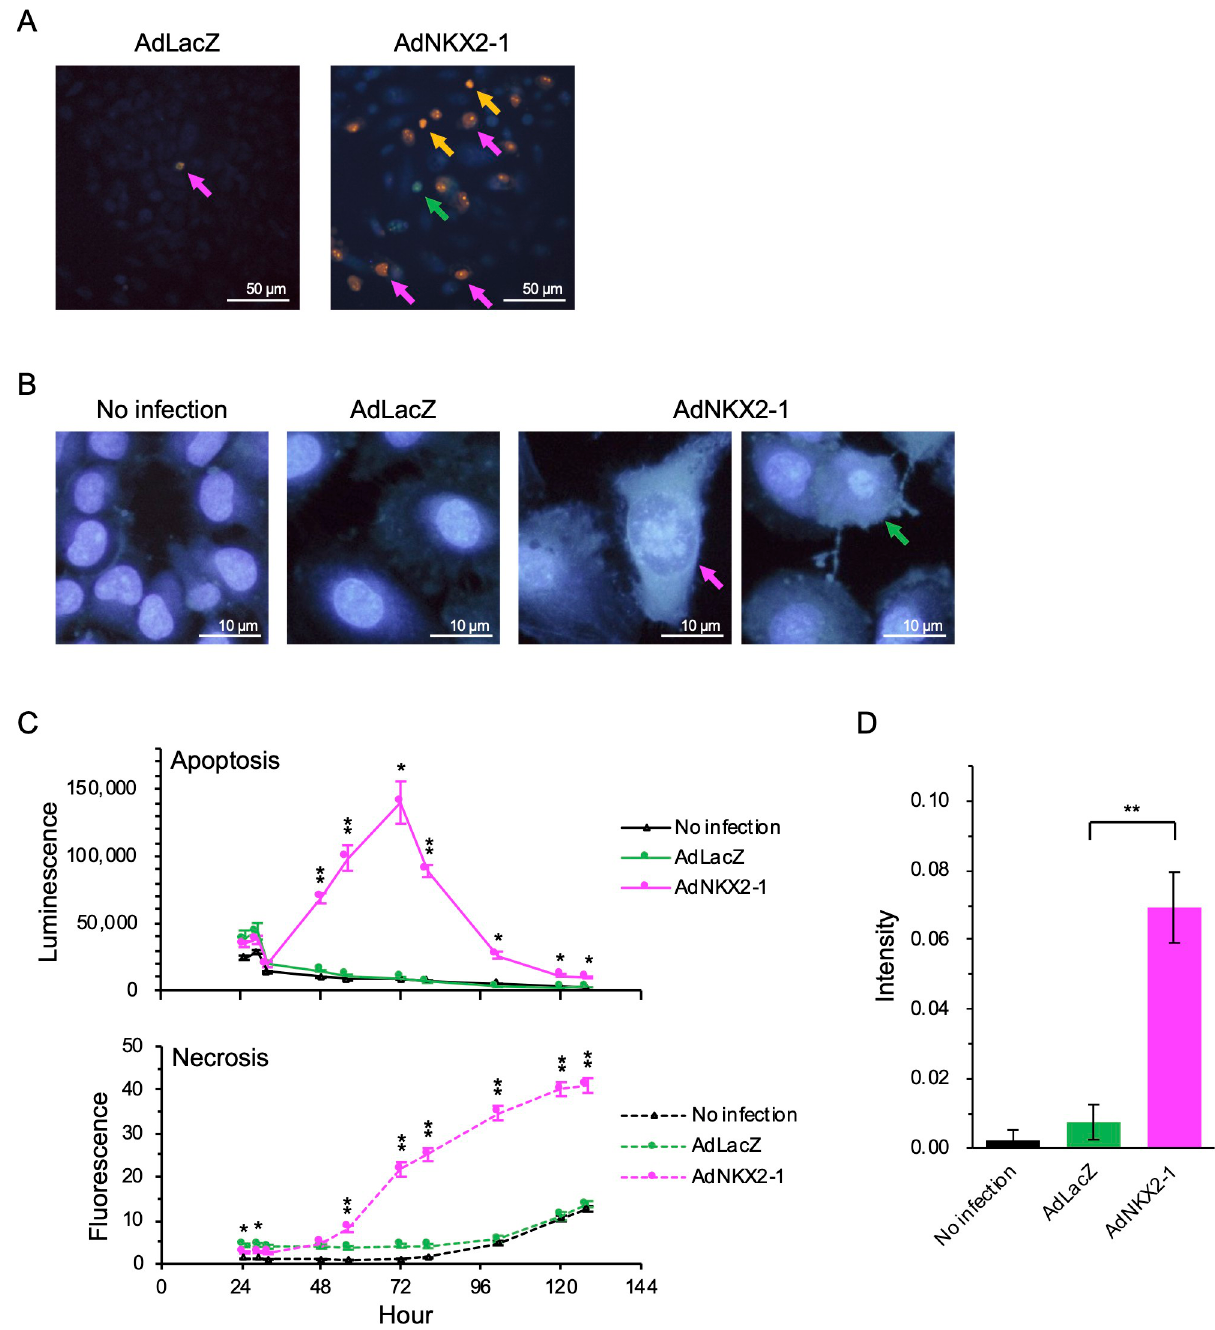
Fig 2. Apoptosis and necrosis detection in BHP18-21v cells after adenoviral vector infection. (A) Acridine orange- and ethidium bromide-stained cells. The green, orange, and magenta arrows represent early apoptotic (acridine orange-stained condensed chromatin), late apoptotic (ethidium bromide-stained condensed chromatin), and necrotic (ethidium bromide-stained normal chromatin) cells, respectively. (B) Hoechst 33342-stained cells. The green and magenta arrows represent an apoptotic cell with a condensed nucleus and a necrotic cell with a ballooning nucleus, respectively. (C) Real-time assay using annexin V (n = 3). The luminescence and fluorescence signals indicate apoptosis and necrosis, respectively. Error bars indicate SEM. � p < 0.05 and �� p < 0.01, significant differences between AdNKX2-1 and AdLacZ. (D) Caspase 3/7 activity-dependent fluorescence intensity 72 h after infection (n = 6). Error bars indicate SEM. �� p < 0.01, significant differences between AdNKX2-1 and AdLacZ.